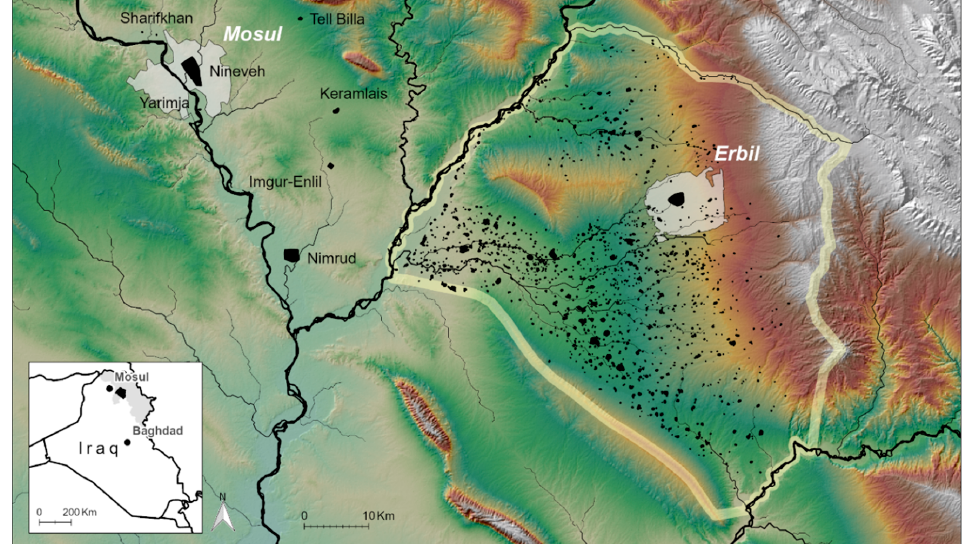
Figure 5. Erbil Plain Archaeological Survey (EPAS) in the Kurdistan Region of Northern Iraq, marked with black fill on grayscale map and yellow outline on the color map. The archaeological sites recorded by EPAS (2012–2018) are marked with black fill within the EPAS survey area. Remote Sens. 2020 , 12 , x FOR PEER REVIEW